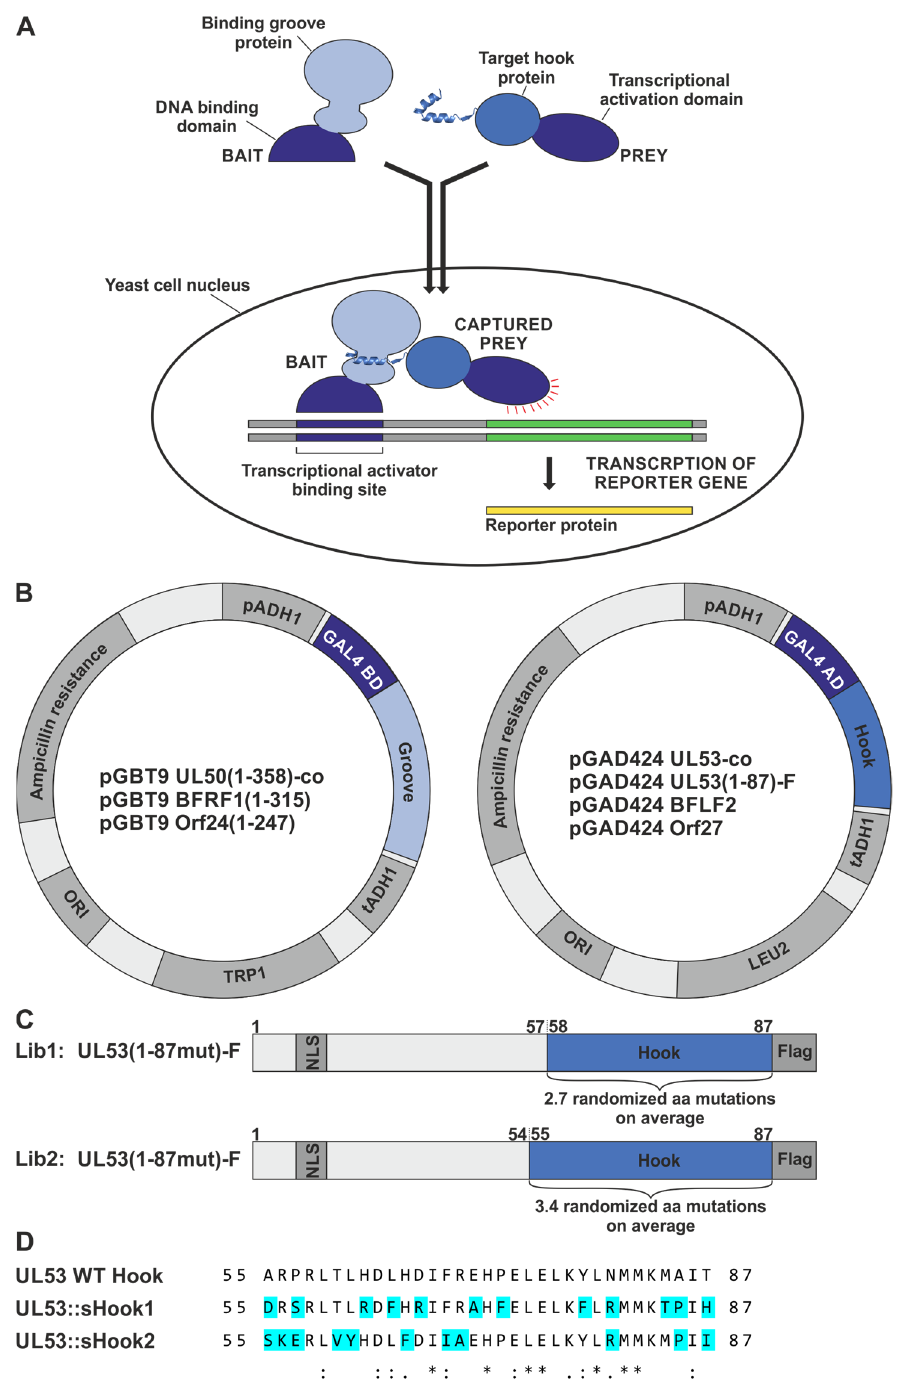
Figure 4. Schematic overview of the Y2H principle, yeast expression constructs and design of the hook mutagenesis libraries of truncated pUL53. ( A ) The Y2H system uses reporter genes to detect the interaction of proteins inside the yeast cell nucleus. The hook ‐ into ‐ groove interaction of a prey hook protein fused to the GAL4 activation domain (AD), with a bait groove protein fused to the GAL4 binding domain (BD), brings together the two ‐ domain transcriptional activator, which then switches on the expression of reporter genes (illustration based on [35]). ( B ) Vector map of yeast expression constructs coding for fusion proteins of the GAL4 AD with hook proteins, here ORF UL53 ‐ co, ORF UL53(1–87) ‐ Flag, ORF BFLF2 and Orf27, and the GAL4 BD fused to groove proteins lacking their transmembrane domain (TMD), here ORF UL50(1–358) ‐ co, ORF BFRF1(1–315) and Orf24(1–247).